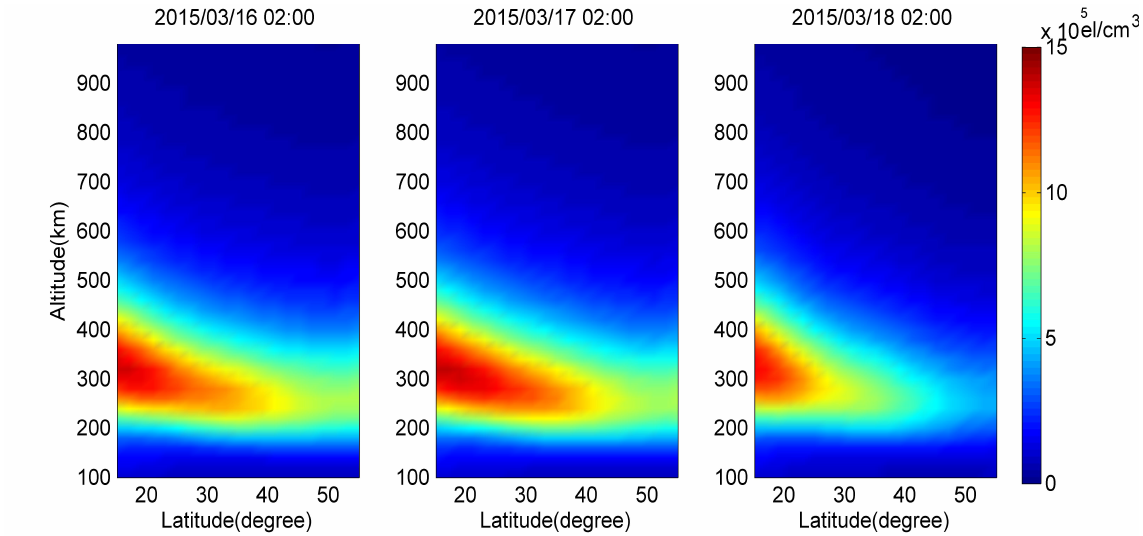
Figure 10. IED profile along latitude and altitude at UTC 2:00 from 16–18 March 2015 (L = 110 ◦ E).